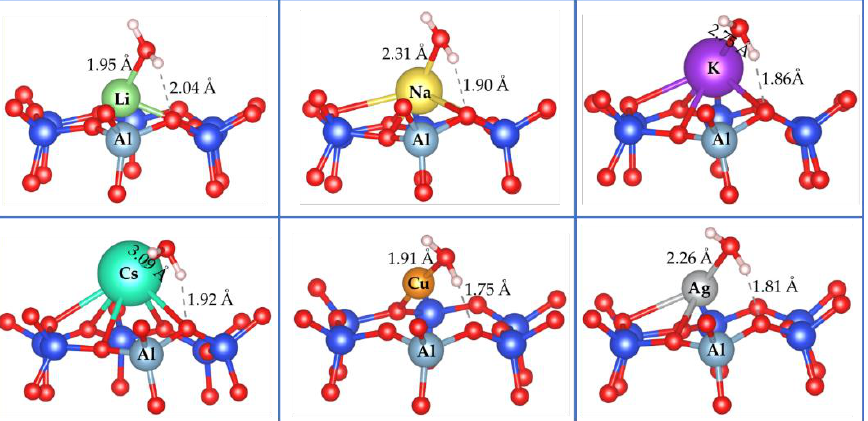
Figure 3. The most stable adsorption modes calculated for water over LiY, NaY, KY, CsY, CuY and AgY. For the sake of clarity, only the 6-MR involved in the adsorption process was displayed. Color codes: silicon in blue and oxygen in red.